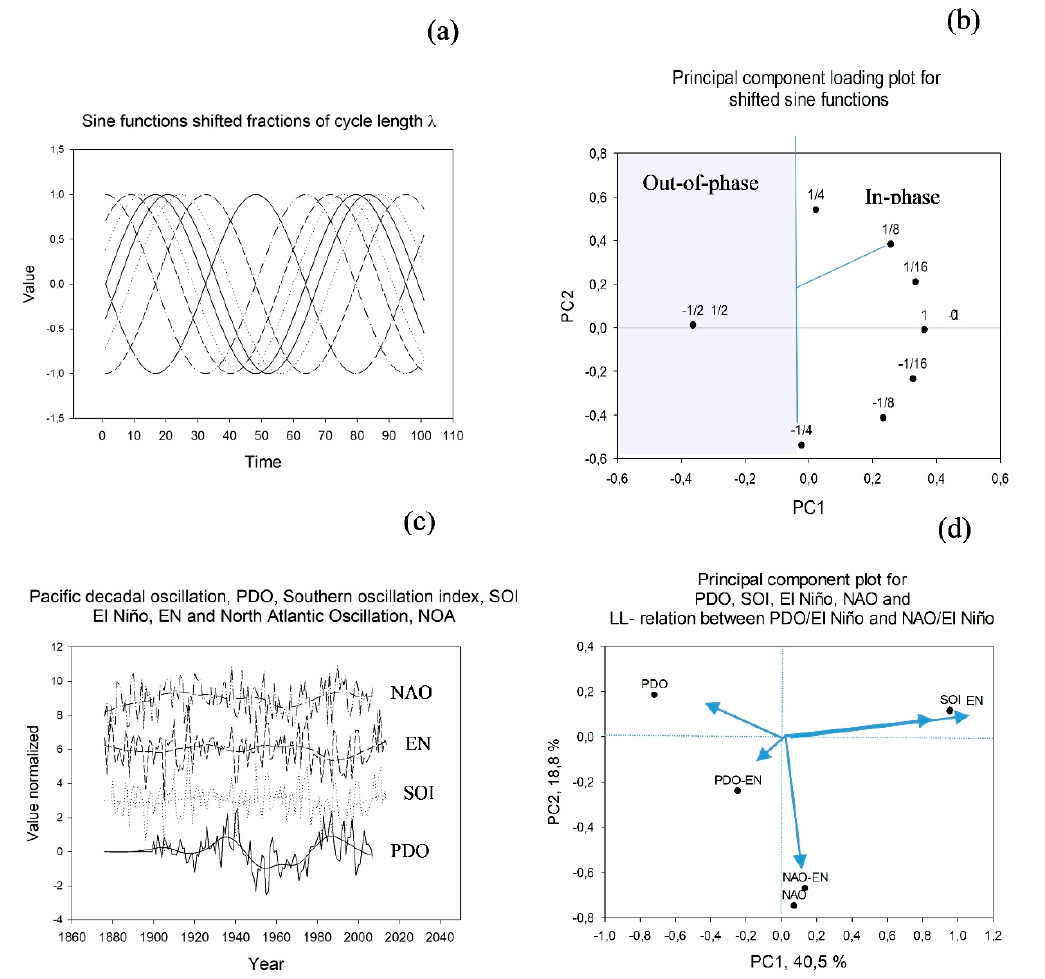
Figure 1. Time series for shifted sine functions and for the four ocean oscillations the Pacific decadal oscillation (PDO), the Southern oscillation index (SOI), El Niño, and the North Atlantic oscillation, (NAO). ( a ) Sine functions that are shifted 1 / 2, 1 / 4, 1 / 8, and 1 / 16 relative to each other; ( b ) principal component loading plot for sine functions; ( c ) ocean oscillations normalized to unit standard deviation and with LOESS smoothed version superimposed; ( d ) principal component plot that include the ocean oscillation time series and leading–lagging (LL) strength: LL (NAO, El Niño) and LL (PDO, El Niño).